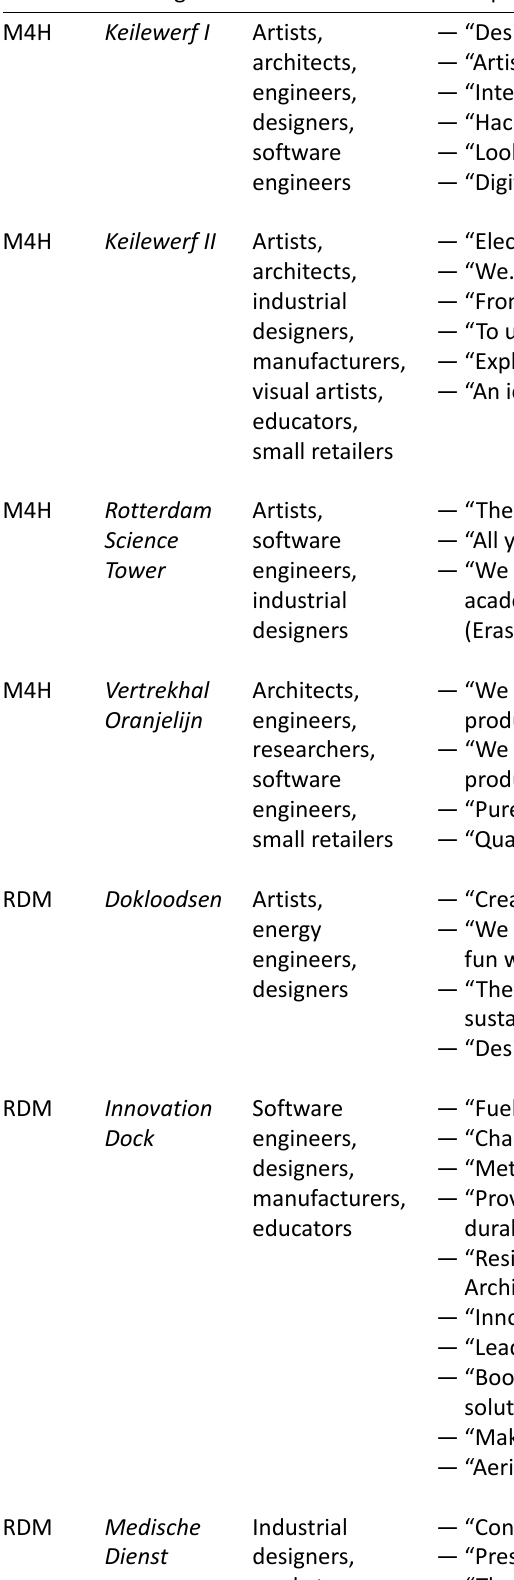
Table 2. Overview of users in Makers District key buildings.